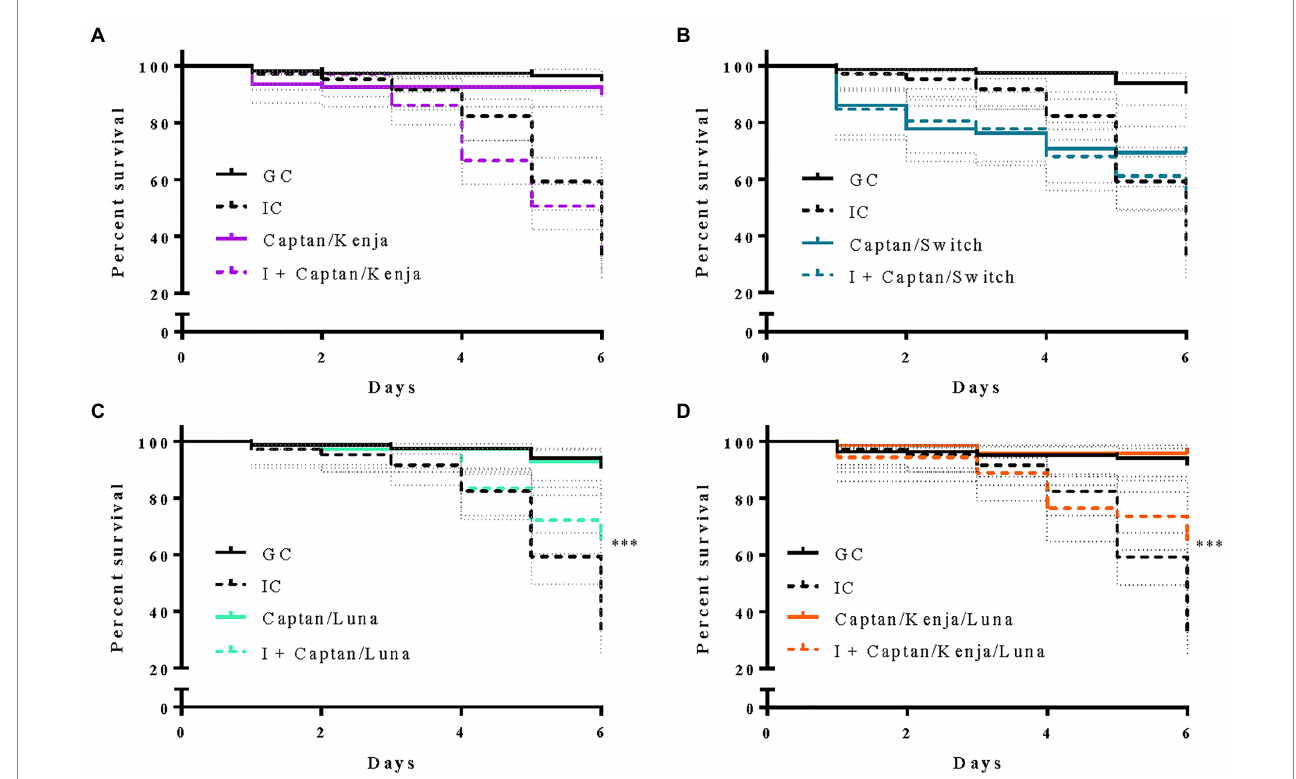
FIGURE 4 Effects of chronic exposure to combinations of fungicidal products on larval survival from European foulbrood disease in vitro. Solid and dashed lines represent percent survival ± confidence interval (dotted grey lines) over 6 days of in vitro rearing of 84–119 grafting control larvae (GC; solid black lines), 72–108 larvae chronically administered a combination of fungicide products (solid colored lines), 105 infected control larvae (IC; dashed black lines) inoculated with 50 colony forming units (CFU) of M. plutonius 2019 BC1, and 72–144 larvae that were infected (I) with 50 CFU of M. plutonius 2019 BC1 and subsequently administered fungicide product combinations in their diet (dashed colored lines). Fungicide-exposed larvae received (A) high concentration Captan and low concentration Kenja, (B) high concentrations of Captan and Switch, (C) high concentrations of Captan and Luna, and (D) high